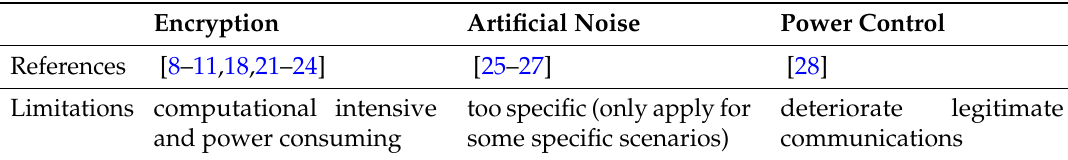
Table 1. Comparison of related anti-eavesdropping schemes in